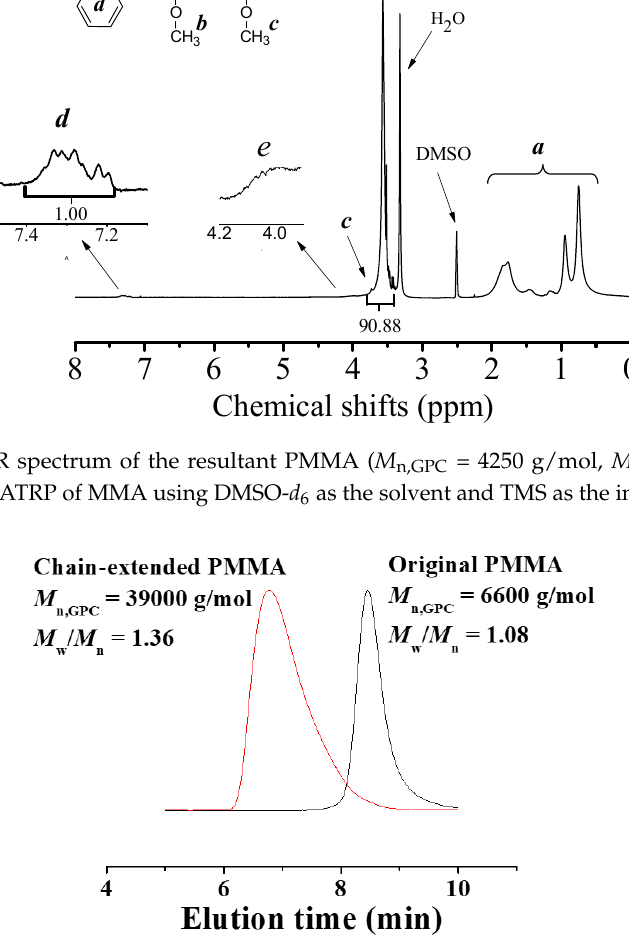
Figure 5. Gel permeation chromatograph (GPC) traces of before and after chain extension using PMMA (obtained by TPSC-based ICAR ATRP of MMA) as the macroinitiator. Original PMMA:[MMA] 0 :[EBPA] 0 :[CuBr 2 ] 0 :[TPMA] 0 :[AIBN] 0 = 200:1:1:1:0.8, V MMA = 1.0 mL, V benzene = 3.0 mL and m PIL = 200.0 mg, temperature = 70 °C. Chain-extended PMMA:[MMA] 0 :[PMMA] 0 :[CuBr 2 ] 0 :[TPMA] 0 : [AIBN] 0 = 200:0.05:1:1:0.8, V MMA = 1.0 mL, V benzene = 3.0 mL and m PIL = 200 mg, temperature = 70 °C.